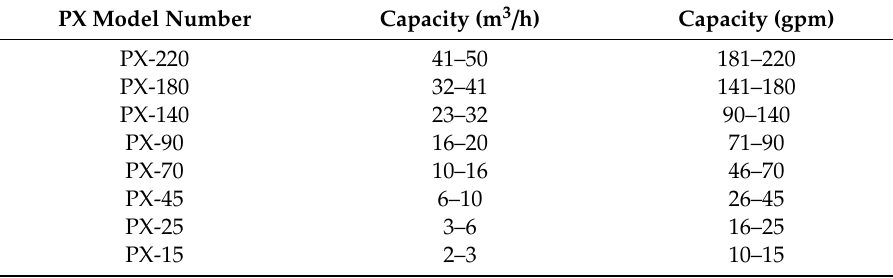
Table 2. The PX sizes available